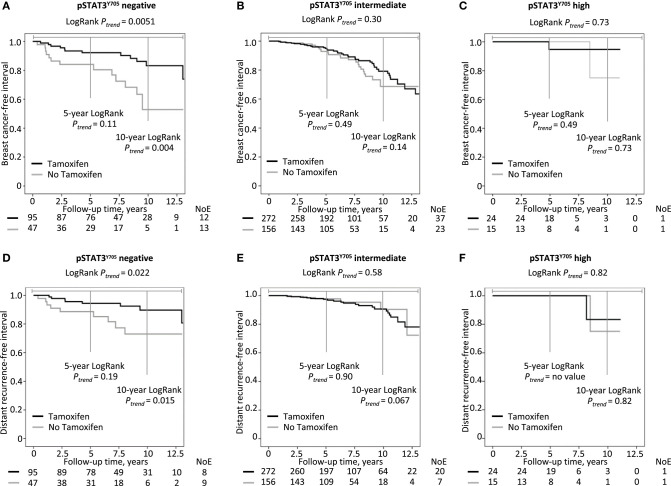
Kaplan-Meier estimates of chemonaïve patients with ER+ breast cancers stratified by tamoxifen treatment in relation to pSTAT3Y705 level: (A–C) breast cancer-free interval, (D–F) distant metastasis-free interval.